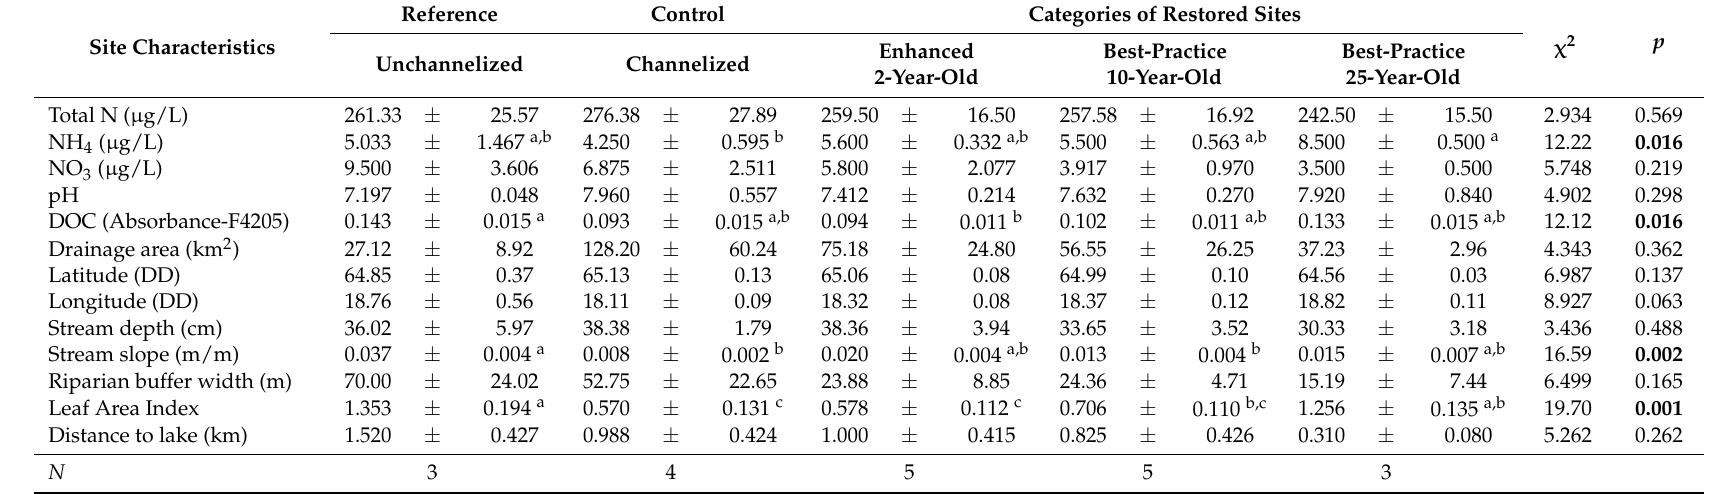
Table A2. Differences for site characteristics among the restoration statuses based on results of linear mixed-effect models (LMM). Differences among the restoration statuses were determined using pairwise comparisons among the least-square means, and equivalent test to Tukey’s honest significant difference test, but for LMMs. Means and standard errors are reported; letters denote significant pairwise differences, values that share letters are not different from each